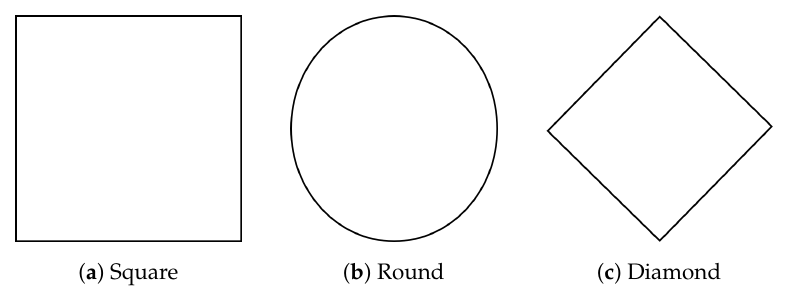
Figure 3. Levels for design factor “Label